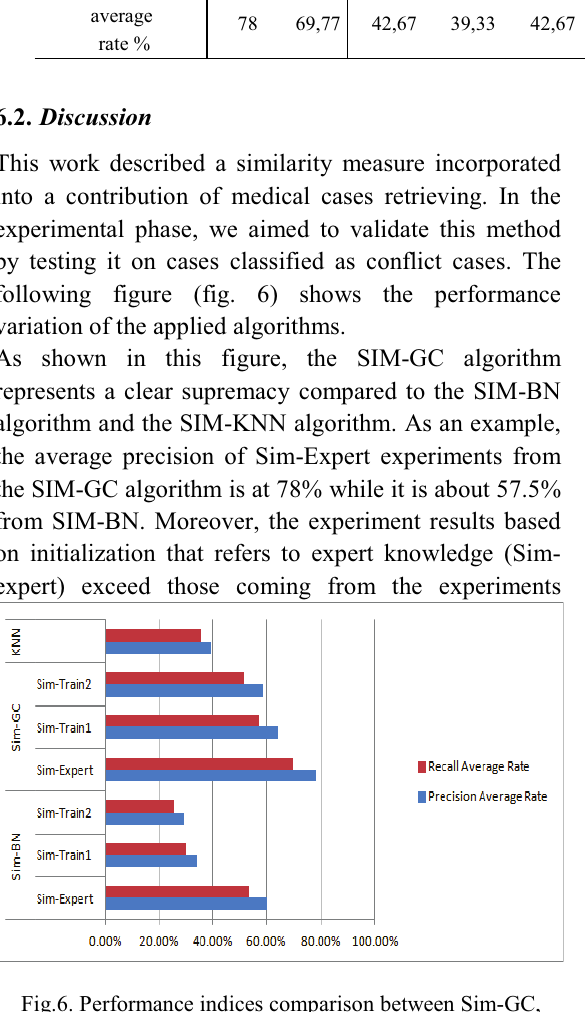
Fig.7. Performance indices comparison between the various tested